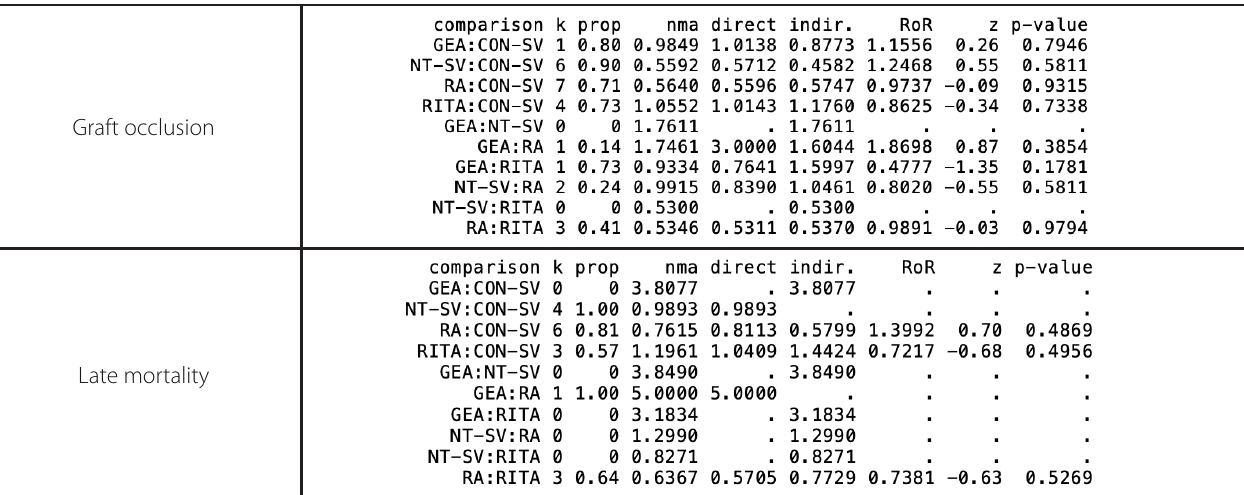
Table S7. Assessment of inconsistency based on separate indirect from direct evidence (or SIDE) using back-calculation method and random effects model.